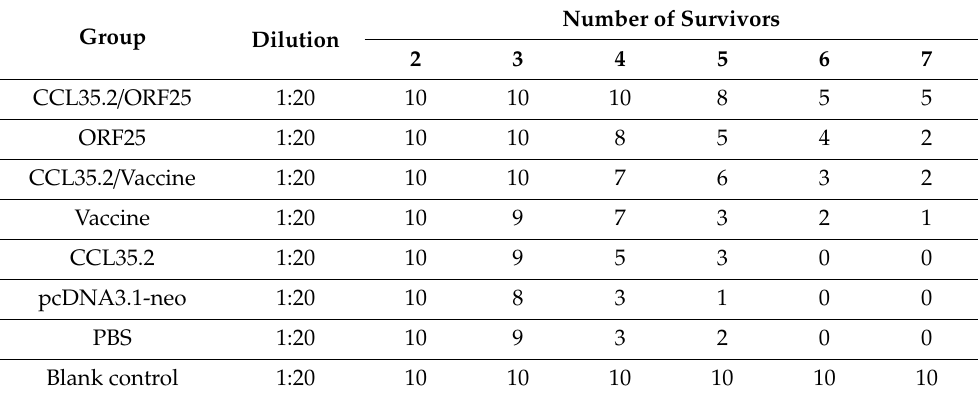
Five animals were randomly selected and gathered serum on 14 dpi before virus challenge. 50 µ L virus (1 × 10 7